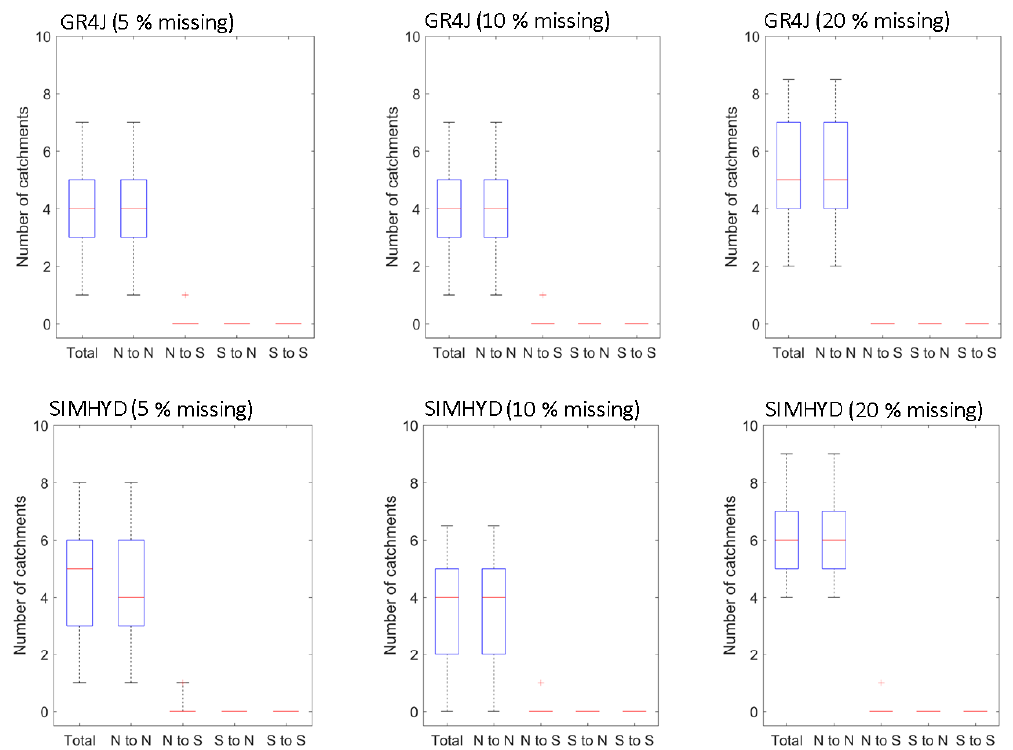
Figure 8. Trend mismatch analysis between the gap-filled and benchmark data. “Total” refers to all the mismatch catchments, “N” denotes non-significant trends ( p > 0 . 05), and “S” denotes significant trends ( p ≤ 0 . 05). The bottom, middle, and top of each box show the 25th, 50th, and 75th percentiles, and the bottom and top whiskers are the 5th and 95th percentiles.